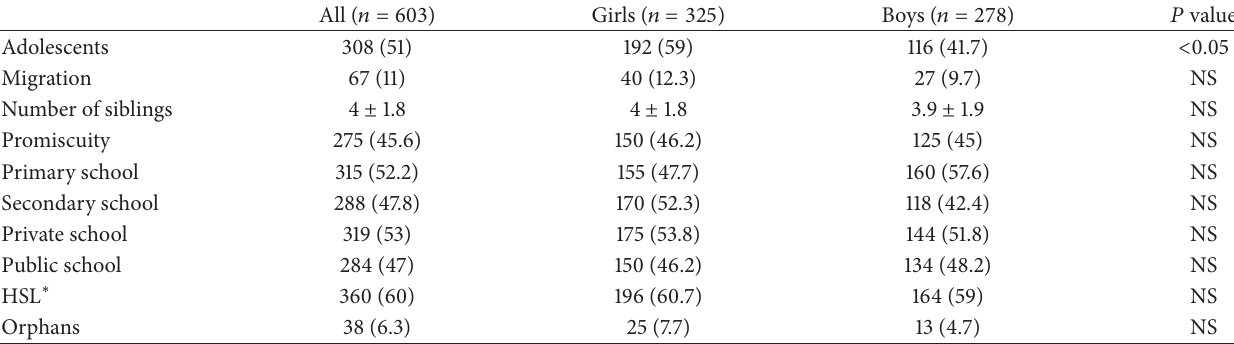
Table 1: Epidemiological characteristics of the children studied.